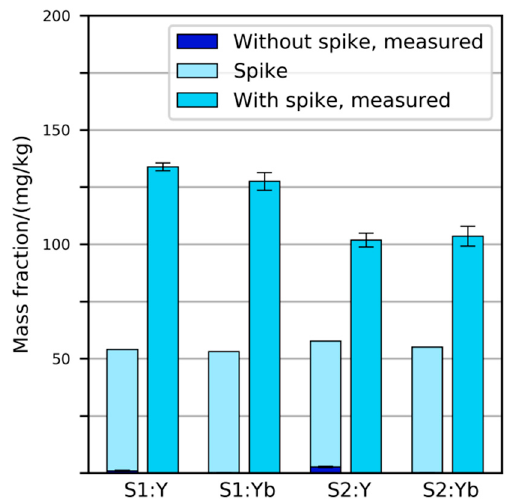
Figure 2. Mass fractions of Y and Yb expected and measured in spiked SLF samples S1 and S2. In all four instances, the measured values were substantially higher than expected. Error bars indicate standard deviation of five repeated digestions/measurements.